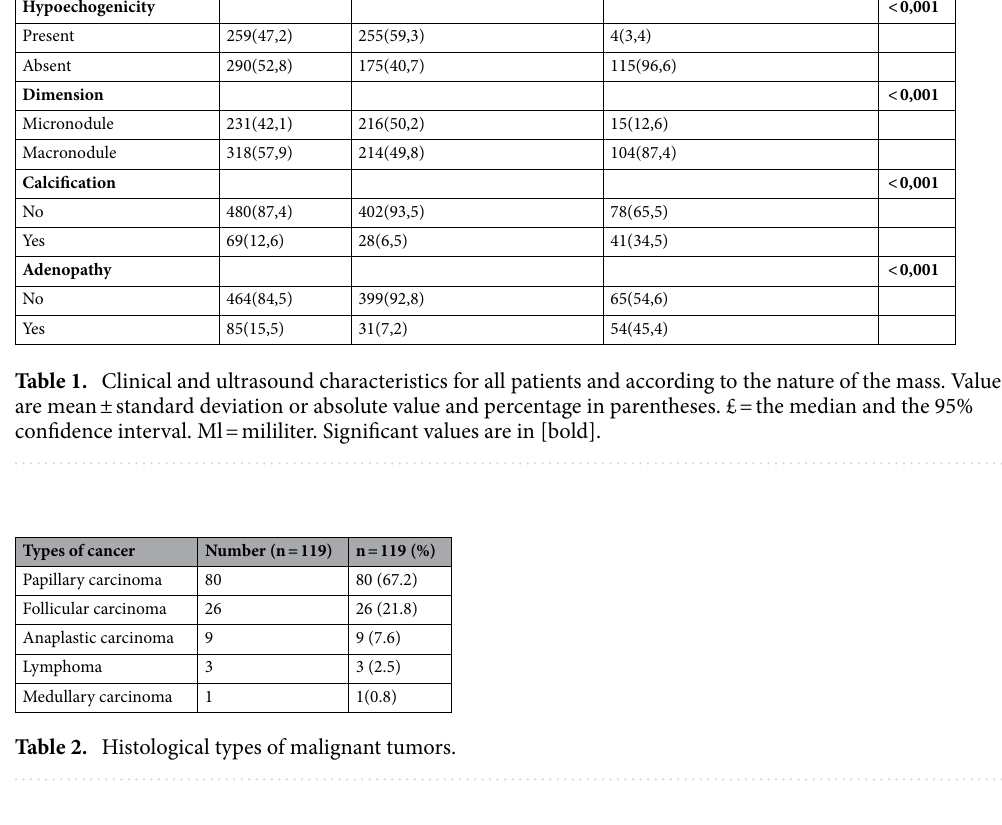
Types of thyroid cancer. Table 2 shows the different types of thyroid cancer. Papillary carcinoma (67.2%) and follicular carcinoma (21.8%) were the most common.